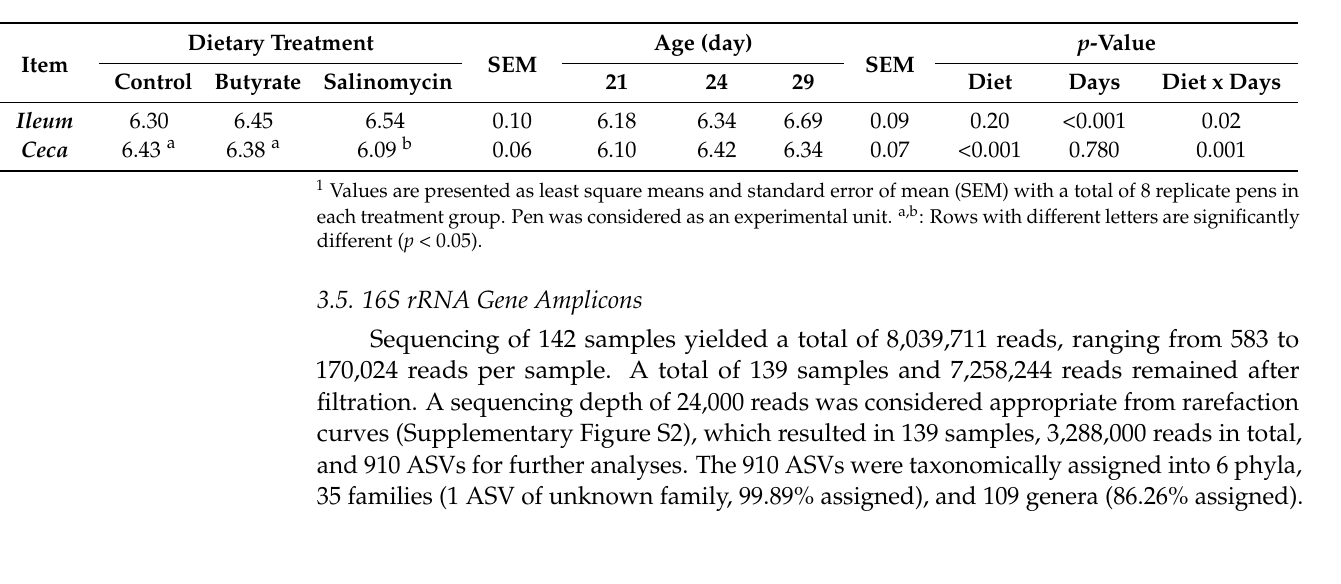
Table 4. pH of digesta from the ilea and ceca of broilers at different ages 1